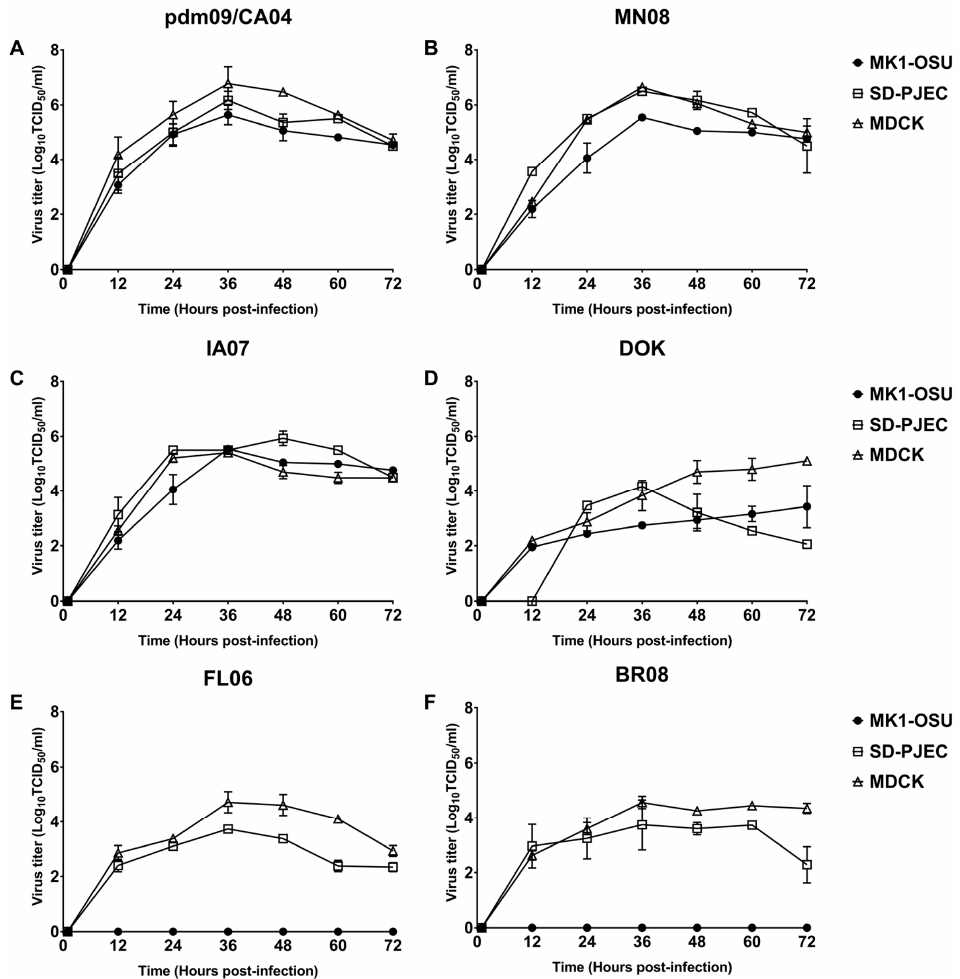
Figure 4. Growth kinetics of type A and D influenza viruses in MK1-OSU, SD-PJEC, and MDCK cells. Growth kinetics of type A and D influenza viruses during 72 h post-infection were measured in MK1-OSU, SD-PJEC, and MDCK cells. Briefly, cells were infected with the influenza viruses at MOI of 0.01 and 100 µL of media was sampled at 12 h intervals until 72 h. Viral 50% infective doses were expressed as log 10 TCID 50 /mL. Values represent the mean ± SE of three experiments for ( A ) pdm09/CA04, ( B ) MN08, ( C ) IA07, ( D ) DOK, ( E ) FL06, and ( F ) BR08.